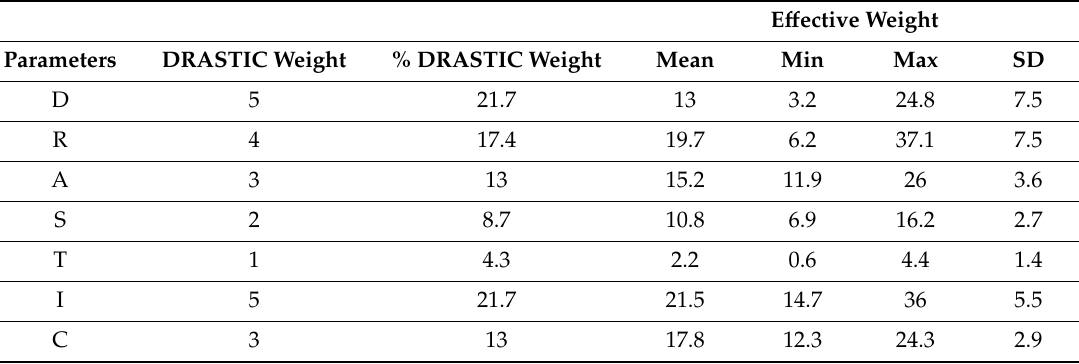
Table 7. Statistics of the single parameters’ sensitivity analysis.